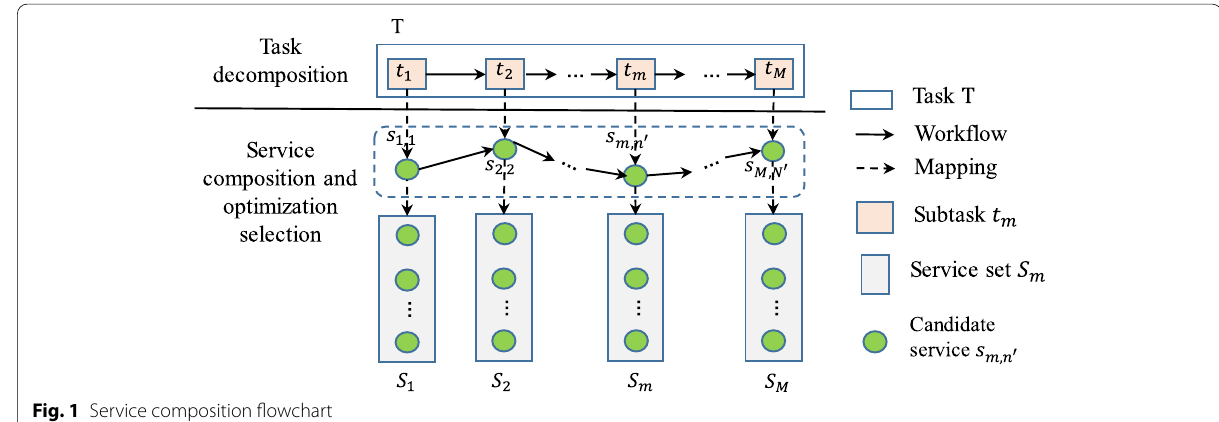
Fig. 1 Service composition flowchart